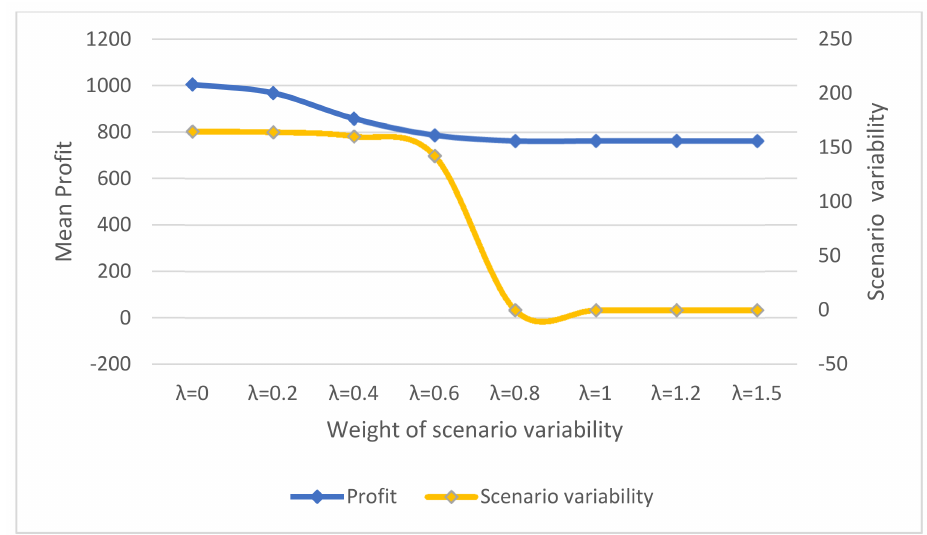
Figure 6. Mean value and scenario variability for different value of λ